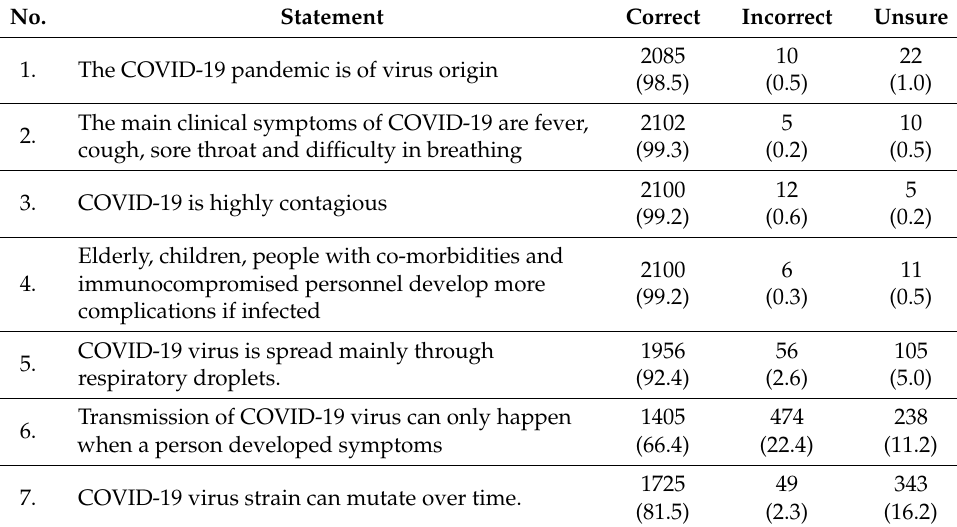
Table 2. Knowledge on COVID-19 ( n =